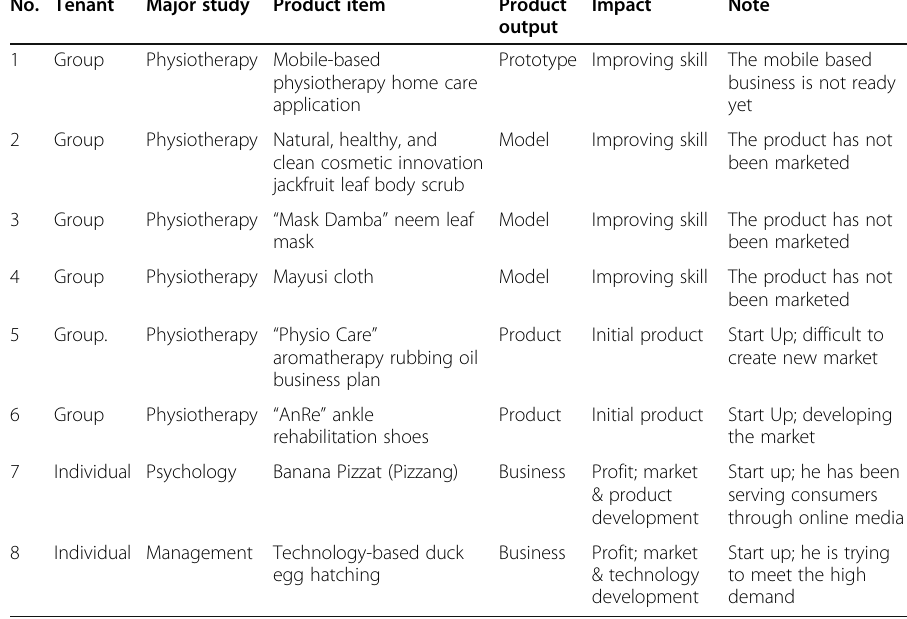
Table 2 Description of tenant No. Tenant Major study Product